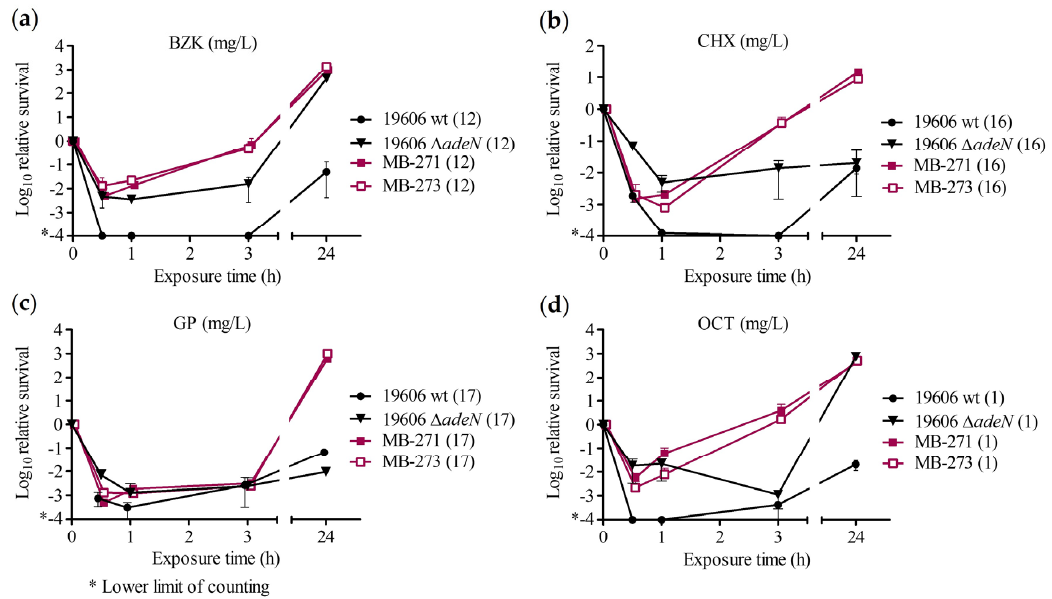
Figure 2. Impact of adeIJK overexpression for laboratory strains A. baumannii ATCC 19606 and A. baumannii 19606 Δ adeN ( adeIJK overexpressed), and clinical strains A. baumannii MB-271 and A. baumannii MB-273 ( adeIJK overexpressed) in the time–kill assay. Time–kill curves of ( a ) benzalkonium chloride (BZK), ( b ) chlorhexidine digluconate (CHX), ( c ) glucoprotamin (GP), and ( d ) octenidine dihydrochloride (OCT). Tested concentrations (mg/L) written in parentheses. Error bars represent the range from three independent experiments.